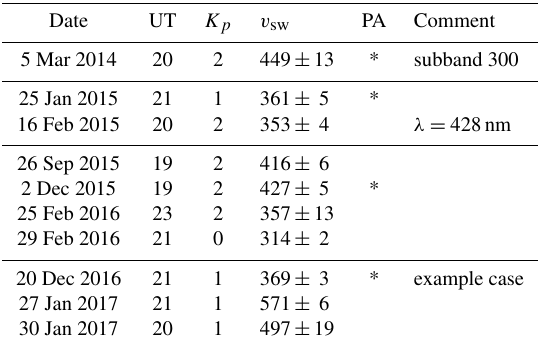
Table 2. Dates of substorm events which have a growth-phase arc with associated CNA. The UT is the approximate time of the growth phase (MLT Kilpisjärvi = UT + 2.5h). Horizontal lines divide the seasons. For each, the K p geomagnetic index and average solar wind speed v sw in kms − 1 is shown. Events showing optical pulsat- ing aurora (PA; Sect. 5.2) are marked. The example event, discussed in detail in Sect. 4, is indicated.